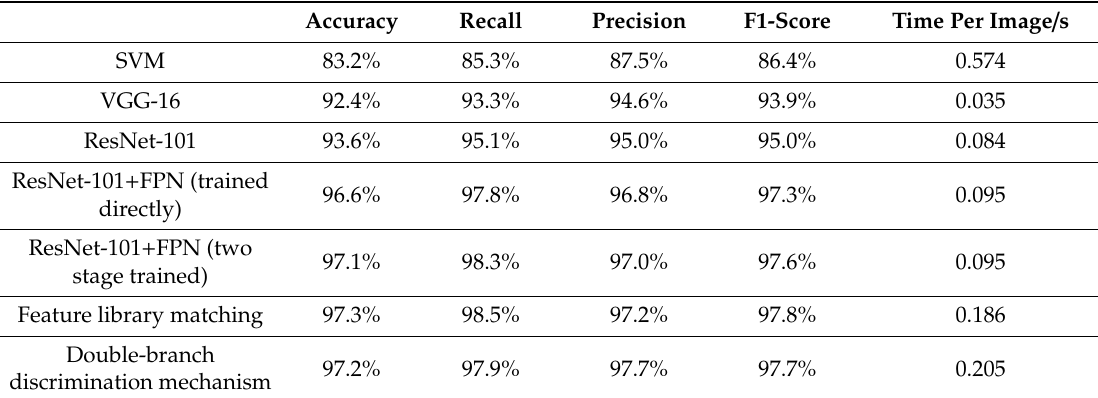
Table 6. A comprehensive comparison of the